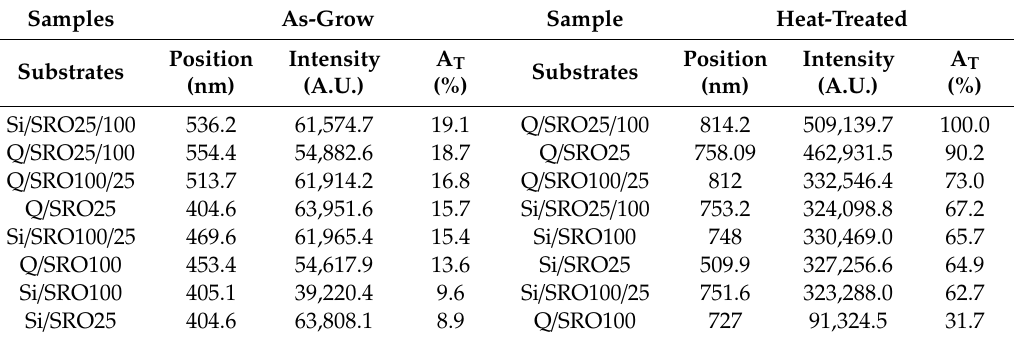
Table 6. Position, intensity, and percentage of the total area of the photoluminescence